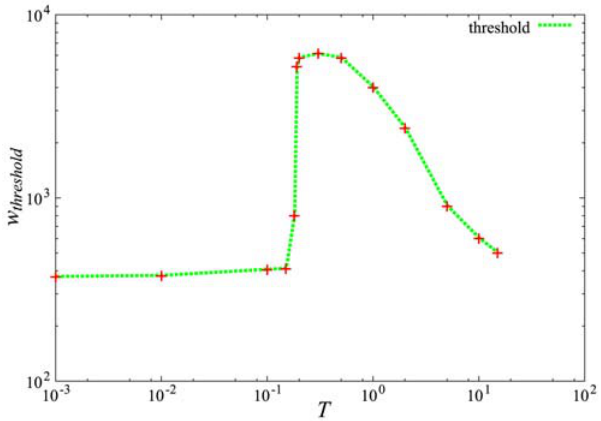
Figure 4. A log-log plot of the threshold ( w threshold ) with respect to the temperature for a fixed number of fatalities. There are three temperature regions: T , 0.2 where the threshold is basically flat, 0.2 , T , 0.5 where the threshold suddenly jumps and reaches a maximum, and T . 0.5 where it decreases monotonically. The threshold has a very wide range of values near 0.2 , T ,